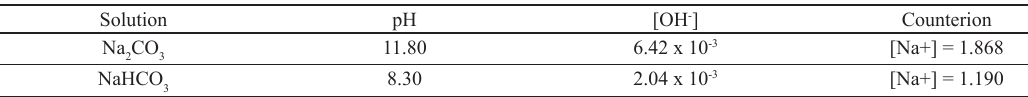
CO and NaHCO 2 3